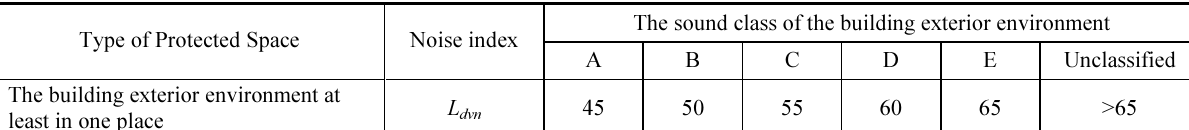
Table 2. Classification of sound pressure levels outside the building originating from traffic. The highest values of A-weighted average long-term noise levels expressed through L dvn (Baltrėnas et al . 2010)